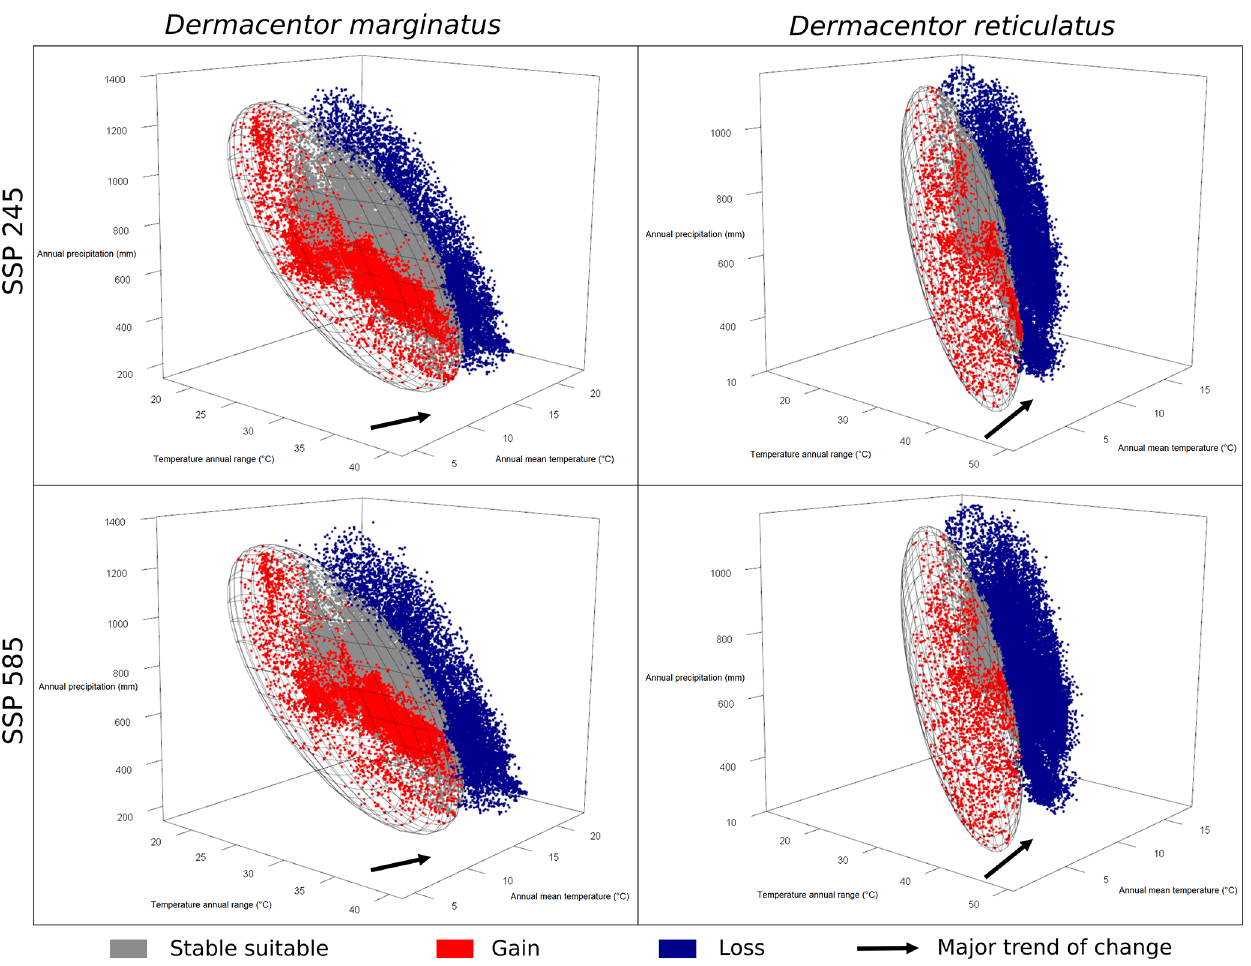
Figure 5. Changes in environmental conditions from the species niches’ perspective, shown for one GCM (CanESM5). Blue dots indicate sites losing suitability. Red dots indicate sites gaining suitability. Gray dots indicate stable suitable